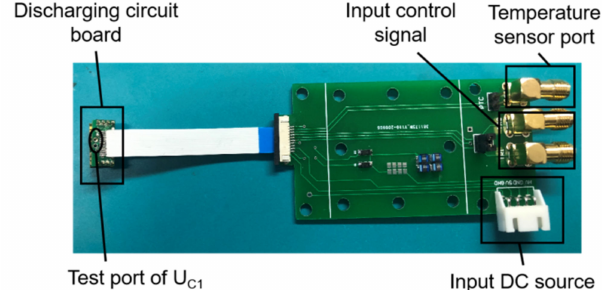
Figure 12. The photo of the experimental prototype.